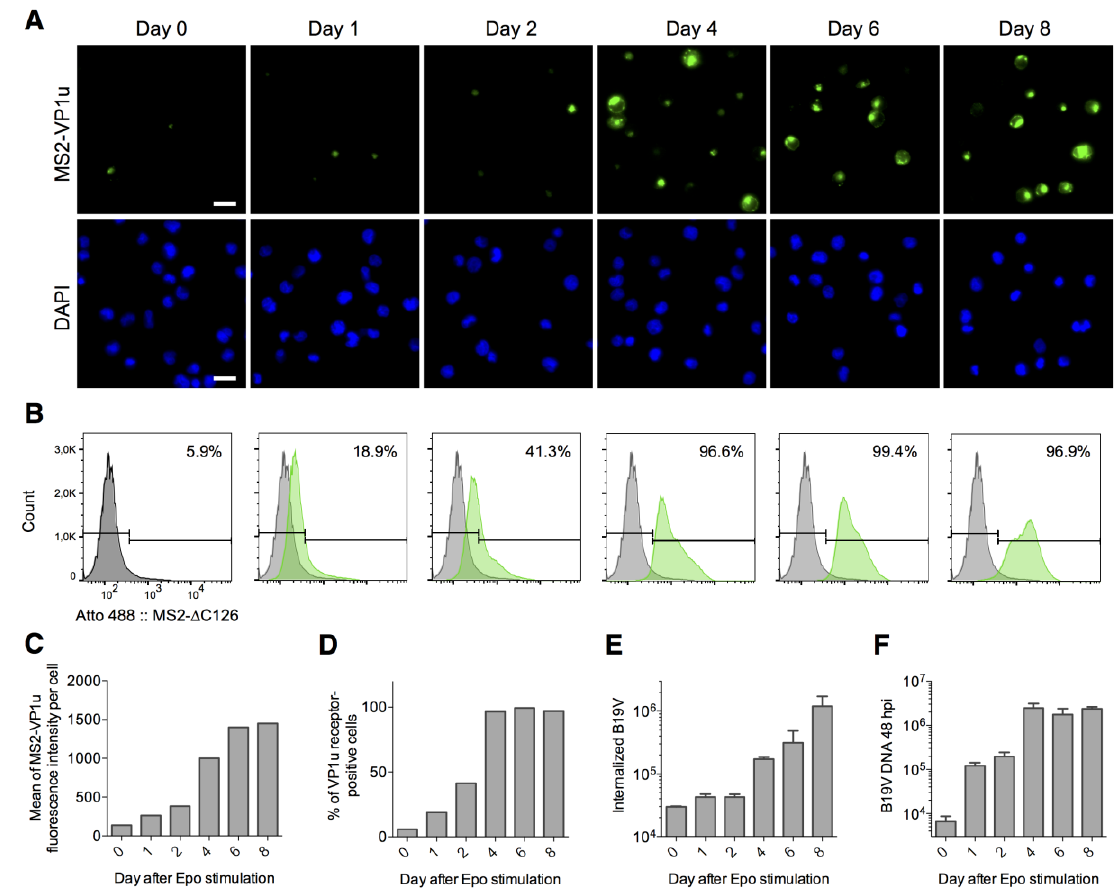
Figure 5. The VP1u receptor is expressed on erythropoietin (EPO)-dependent erythroid differentiation stages: CD34+ hematopoietic stem cells were expanded in StemCell medium and then stimulated with 3 U/mL EPO. VP1u receptor expression, B19V uptake and infection were tested at different days after EPO-stimulation. ( A ) Fluorescence microscopy images and ( B ) flow cytometry analysis of MS2-∆C126 VP1u uptake into differentiated cells; ( C ) Histograms of the FACS data, showing the mean fluorescence of MS2-VP1u internalization per cell and ( D ) number of VP1u receptor-positive cells; ( E ) Quantification of B19V uptake and ( F ) infection before (day 0) or after stimulation with EPO ( n = 3). Scale bar: 15 µm.